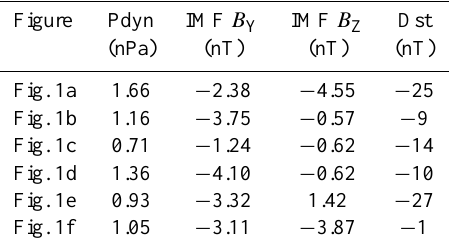
Table 1. Input parameters for T01 model as used in Fig.